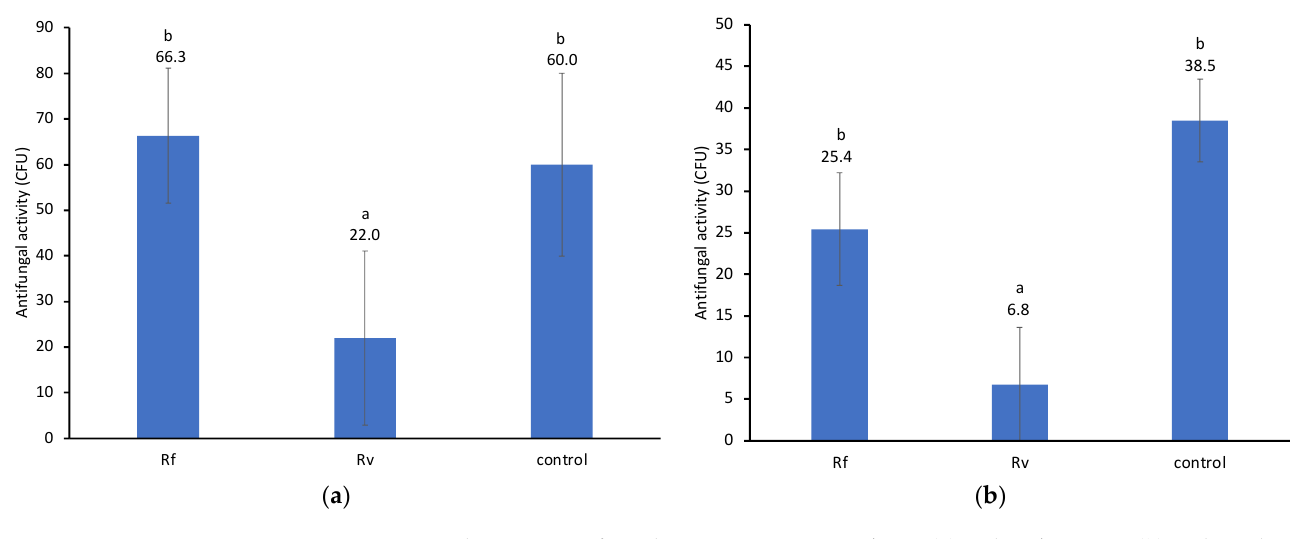
Figure 5. Crude extract antifungal activity against M. robertsii ( a ) and M. brunneum ( b ). Values above bars represent mean CFUs (±SD), and different letters indicate significant differences (Bonferroni adjusted). Rf corresponds with R. flavipes and Rv with R. virginicus . The analysis used two replicates from 5 colonies from each termite species, 6 replicates for the Rf control, and 2 replicates for the Rv control.